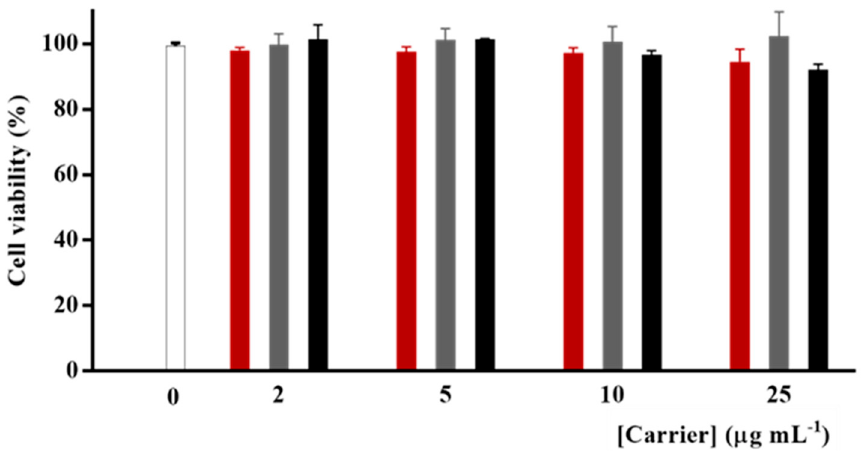
Figure 6. U87 viability after treatment with empty γ -Fe 2 O 3 ( red ) and NGO ( grey ) and γ -Fe 2 O 3 @NGO ( black ).